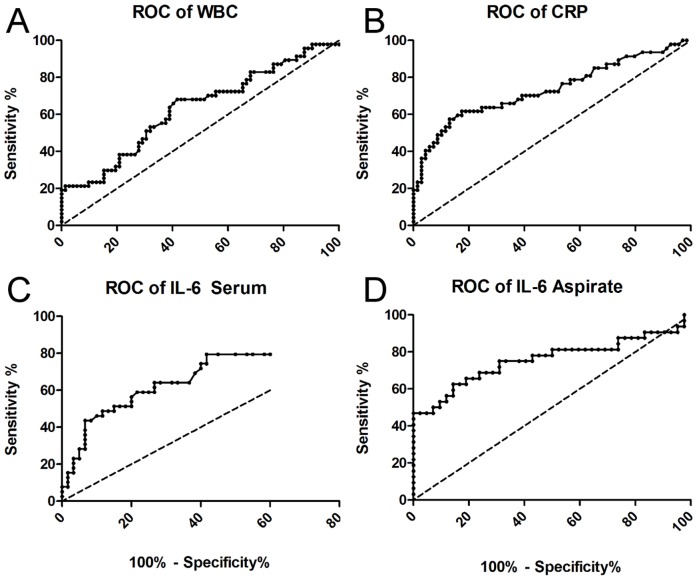
ROC curves of the markers measured.The curves A–D present the receiver-operator-characteristics curves of the parameters measured, depicting the area under the curve as an indicator for discriminatory strength. The line of identitiy is plotted as a dashed line in each graph.